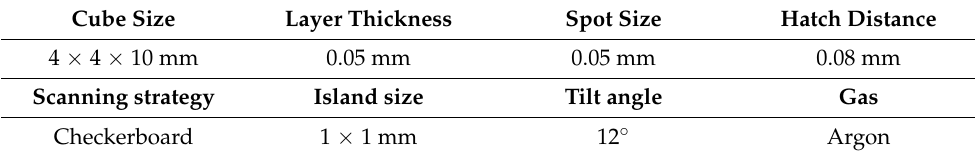
Table 1. LPBF (laser powder bed fusion) parameters used to create the parameter study. Cube Size Layer Thickness Scanning strategy Island size Tilt